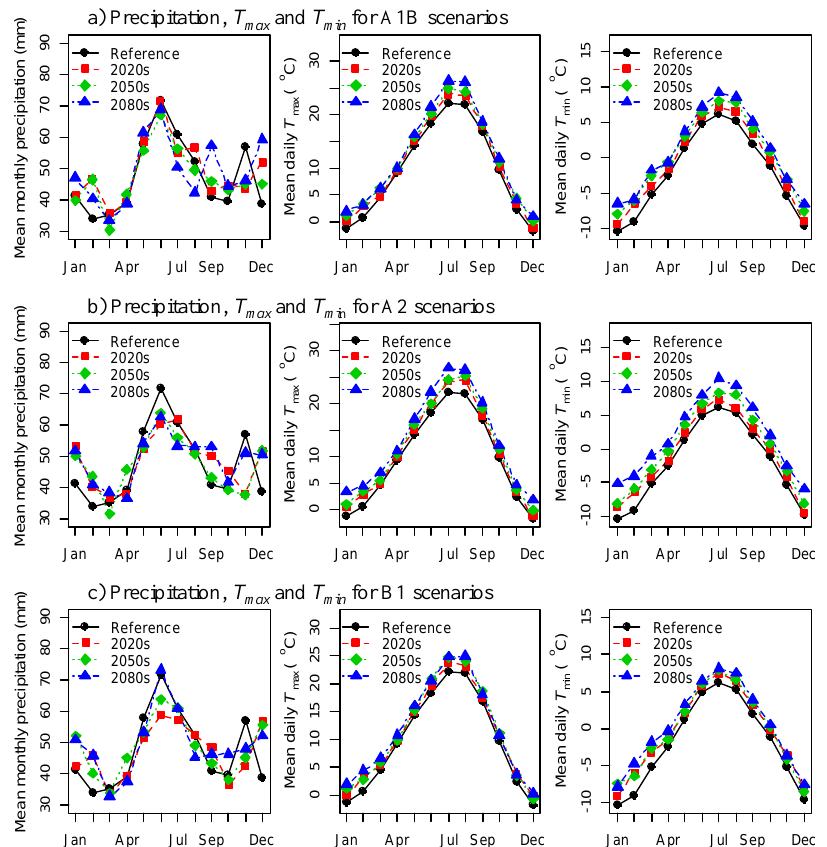
Fig. 2. Reference (observed) period daily climates aggregated to monthly scale and nine sets of future monthly climate means (precipitation, T max and T min ) estimated for climate station,